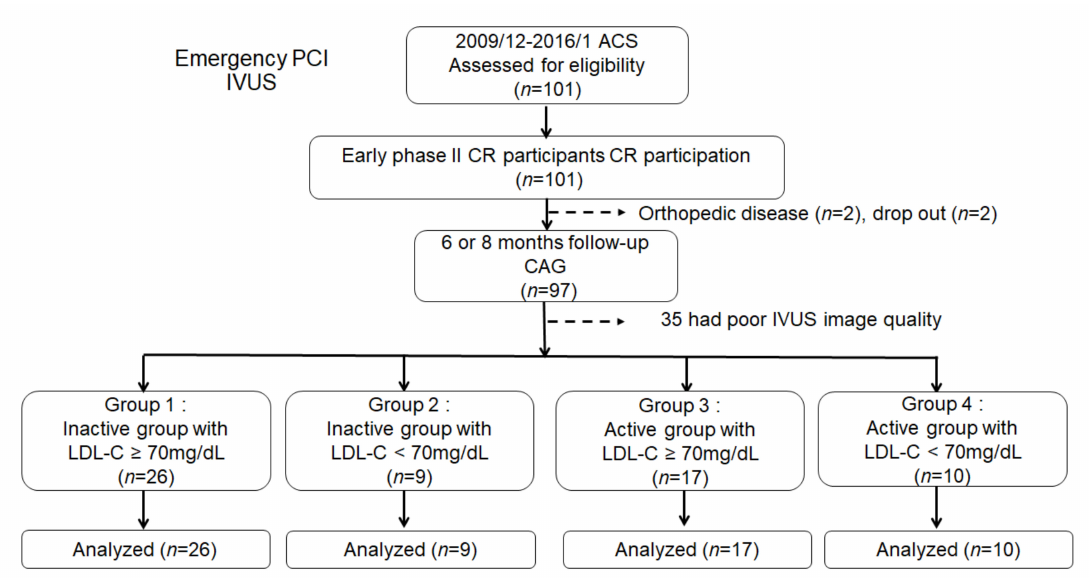
Figure 1. Study flow chart. Inactive group: Physical activity < 7000 steps / day, Active group: Physical activity ≥ 7000 steps / day. PCI, percutaneous coronary intervention; IVUS, intravascular ultrasound;